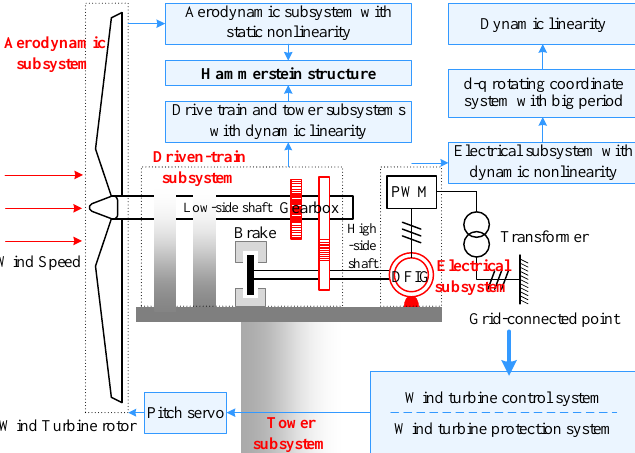
Figure 1. Modern variable-speed variable-pitch (VSVP) wind turbine under the Hammerstein structure. During wind energy capture, the aerodynamic system contributes the main nonlinearity.